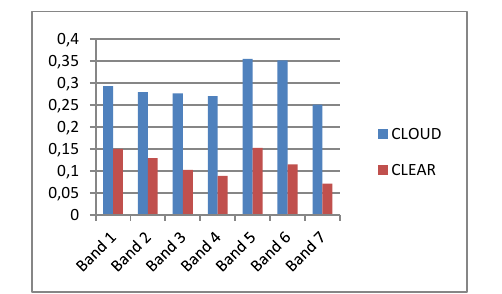
Figure 3. The difference of reflectance values between clear pixels and cloud contaminated pixels on water bodies.